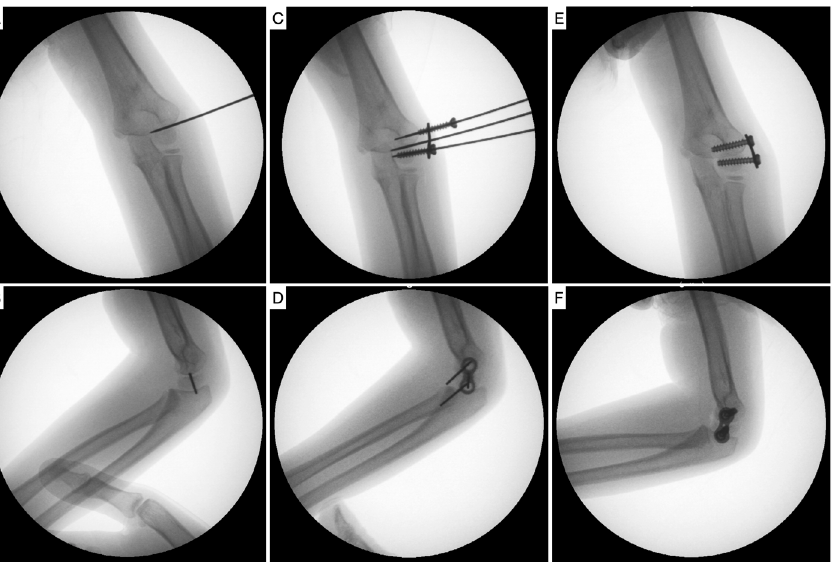
Figure 2. ( A , B ) Guide wire placement in the lateral humeral condyle physis centered in both planes. ( C , D ) Placement of the eight-Plate, guide wires, and proximal and distal screws in both projections. ( E , F ) Final check of correct position of the eight-Plate and screws.